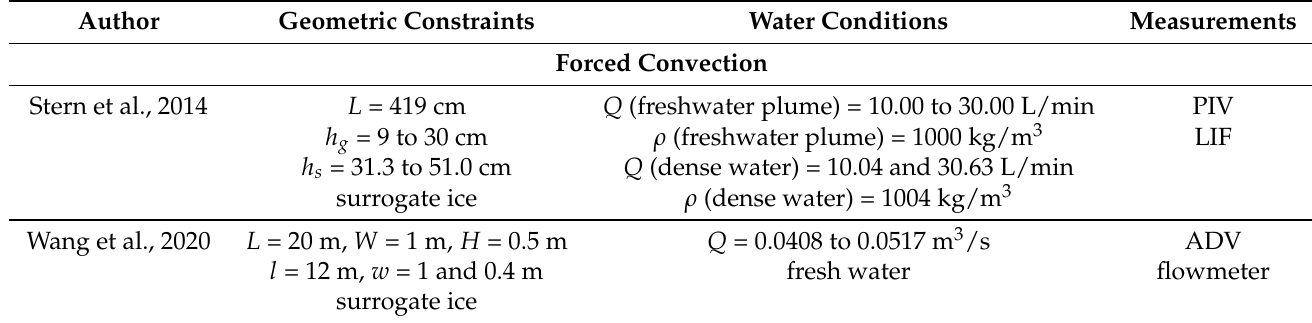
Table A8. Experiments focused on flow patterns and melting in an ice channel in forced